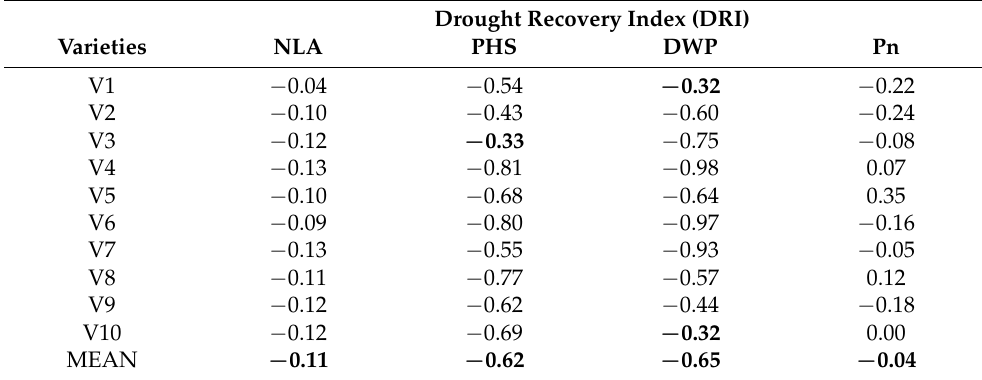
Table 3. Drought recovery index of sorghum varieties on some growth